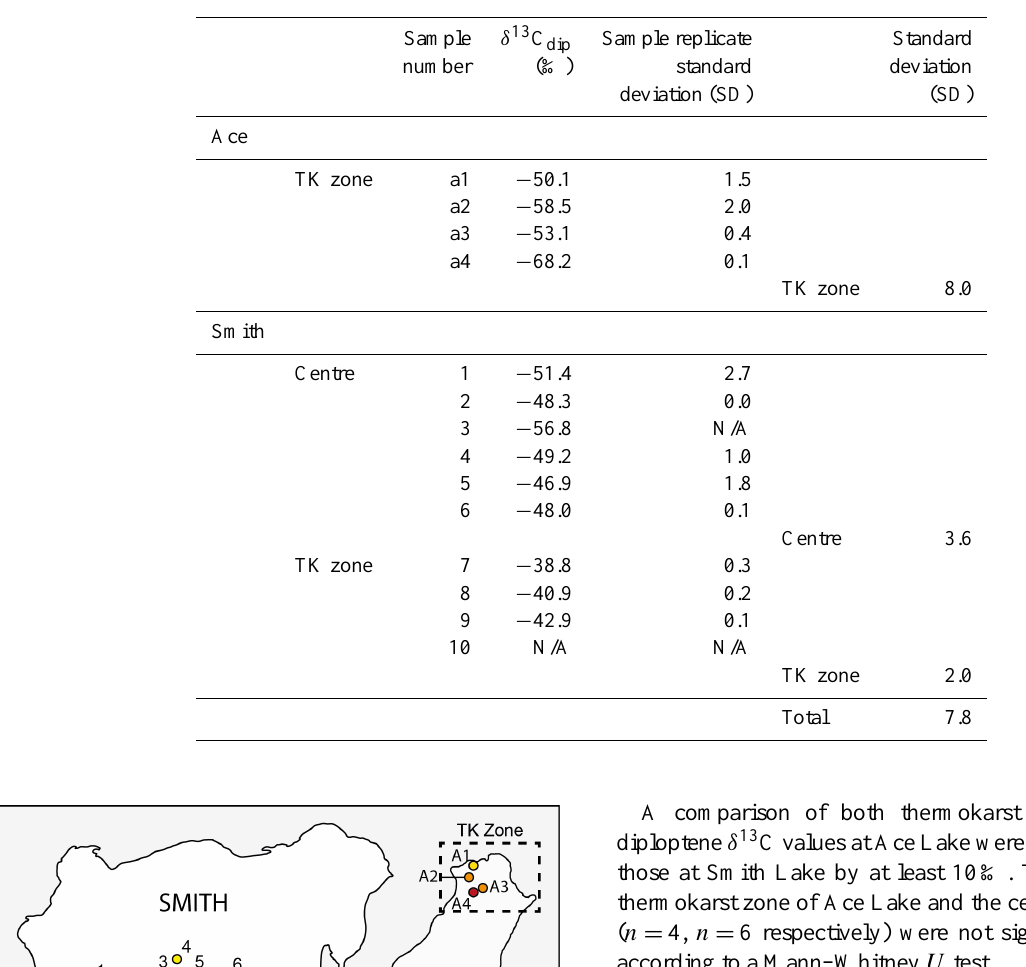
Table 2. δ 13 C values of diploptene at the study sites. The values are an average of three replicates. The standard deviation of these replicates and of each zone and across all samples is also given.